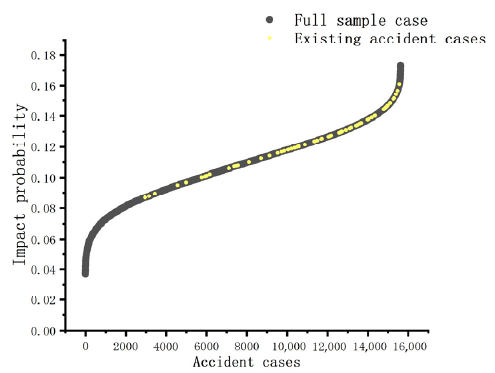
Figure 6. Accident cases and full sample impact probability